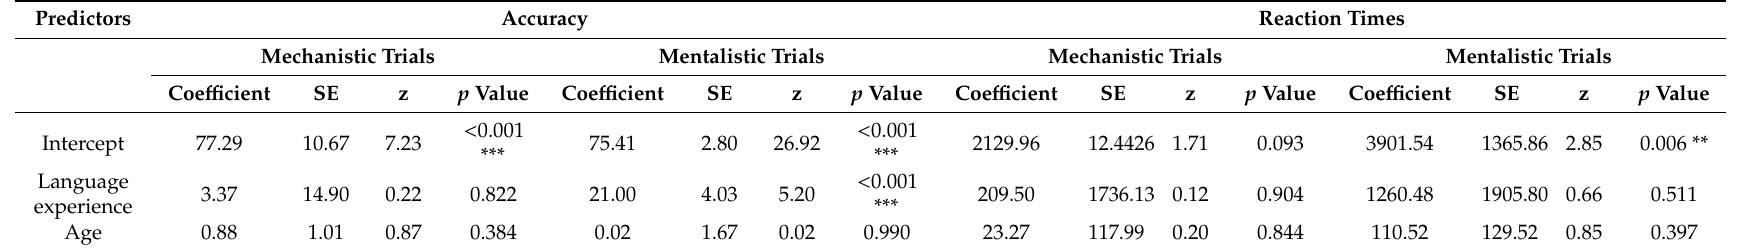
Table 11. Summary of logit mixed e ff ects models: Low-verbal Theory of Mind